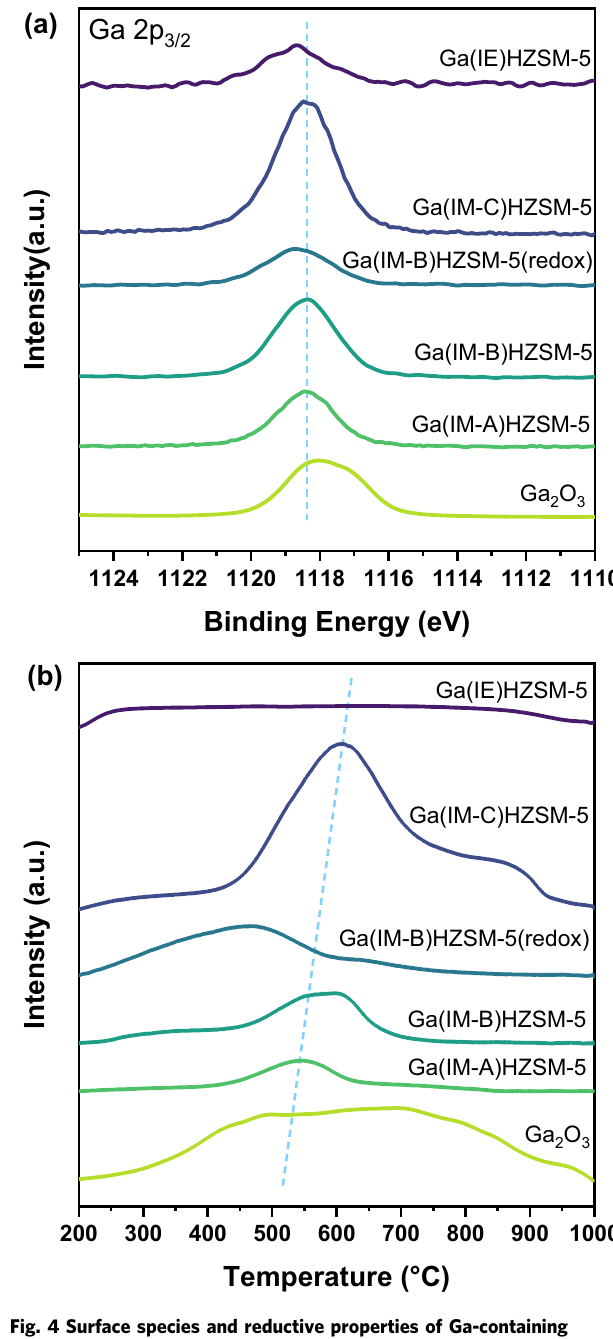
Fig. 4 Surface species and reductive properties of Ga-containing samples. a XPS Ga 2p 3/2 spectra of pure Ga 2 O 3 and Ga-modi fi ed